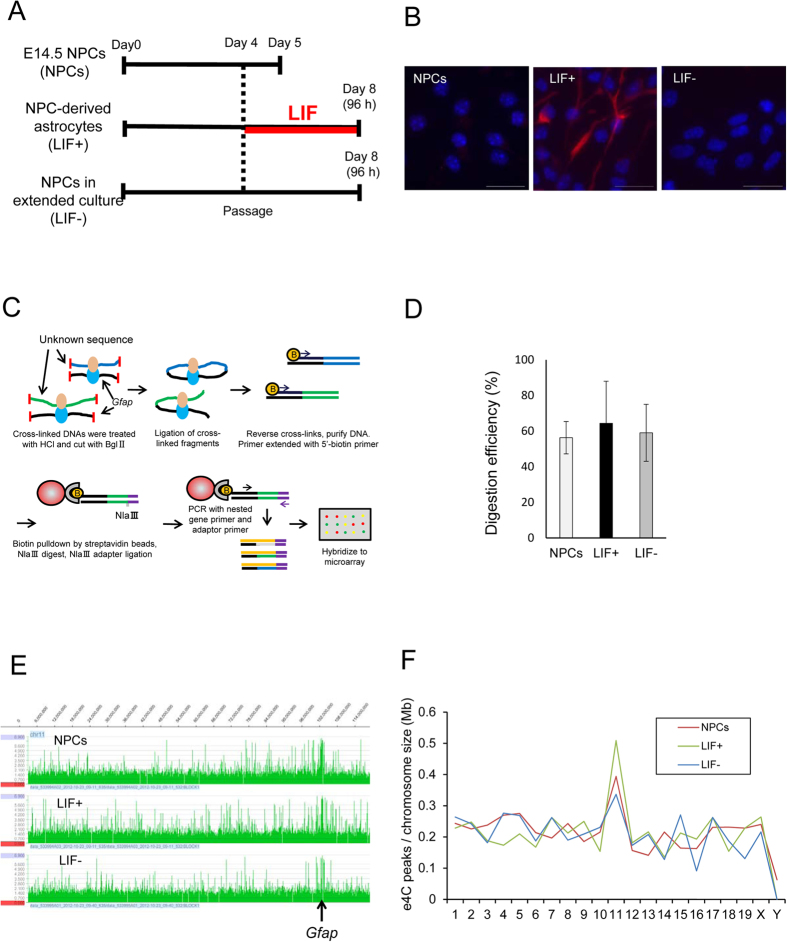
Genome-wide interactions of the Gfap loci in NPCs, LIF+, and LIF− cells.(A) Schematic experimental protocol. NPCs isolated from E14.5 mouse telencephalon were cultured and replated on day 4. On day 5, cells were used for experiments as NPCs. NPC-derived astrocytes and NPCs in extended culture were collected after an additional 4 days of culture with or without LIF. On day 8, the cells were used for experiments as LIF+ or LIF− cells. (B) NPCs, LIF+, and LIF− cells were stained with an anti-GFAP antibody (red, GFAP; blue, DAPI). Scale bar = 20 μm. (C) Schematic representation of the modified e4C method. Chromatin was fixed in paraformaldehyde and treated with 0.1 N hydrochloric acid, then digested with BglII and ligated. The resulting hybrid molecules were used as a template for the primer extension reaction using the bait-specific primer. This was followed by adaptor ligation, nested PCR, labelling with fluorescent dye, and hybridization to a custom microarray. (D) The digestion efficiency of the DNA samples used for modified e4C. Relative amounts of PCR products on a BglII recognition site located near the Gfap STAT3 binding site (GSBS) are shown. (E) Association profiles were determined as the signal ratio of e4C samples to reference genomic DNA. Log2 (e4C DNA/genomic DNA) = 2 was set as a cut-off value. (F) Number of e4C peaks on each chromosome. Chromosome sizes were obtained from the Mouse Genome Browser Gateway (NCBI37/mm9).